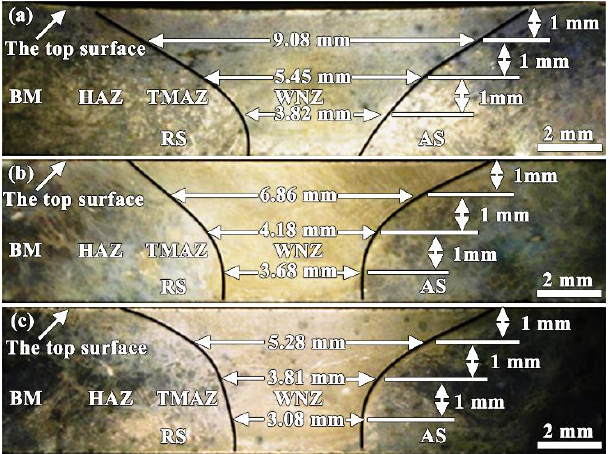
Figure 7. The macrostructures of the joints under: ( a ) the FSW condition; ( b ) the HFSW-W condition; ( c ) the HFSW-IW condition.